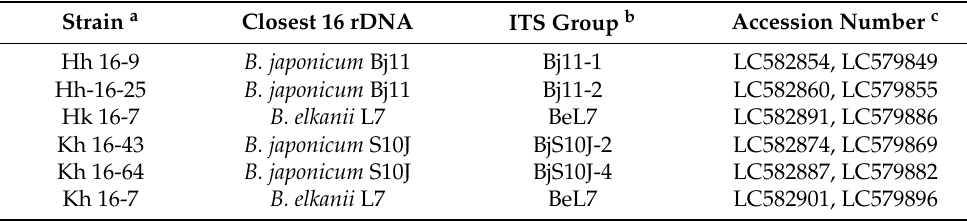
Table 1. Bradyrhizobium strains used in this study.